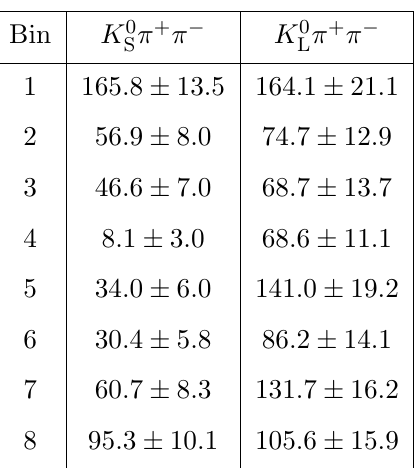
(cid:25) + (cid:25) (cid:0) (cid:25) 0 decays tagged with S